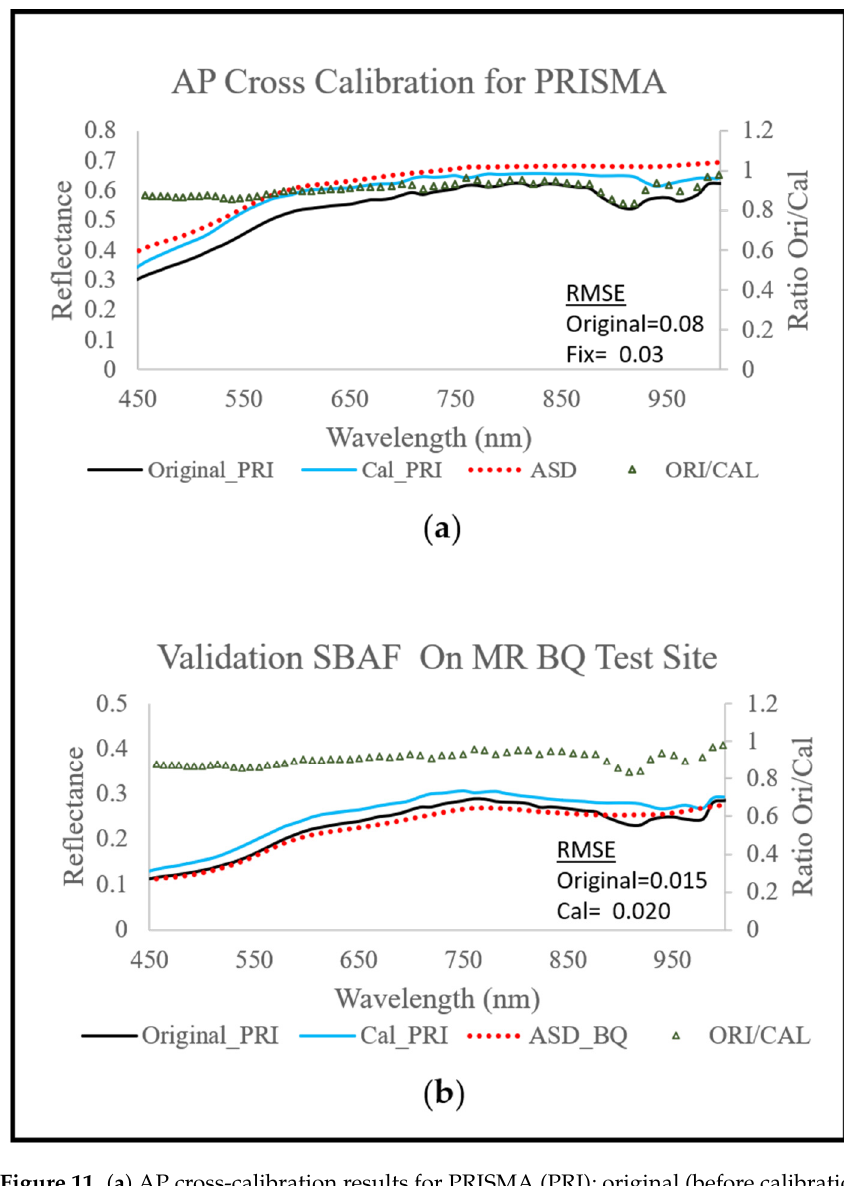
ground-truth ASD spectrum (dashed red line). Though the brown questa spectra from the original PRISMA signal, the calibrated signal, and the ASD spectra were similar, it can be seen that the noticeable artifacts in the original L2D signal (before calibration, black line) at 900–1000 nm were less pronounced after the cross-calibration (blue line).